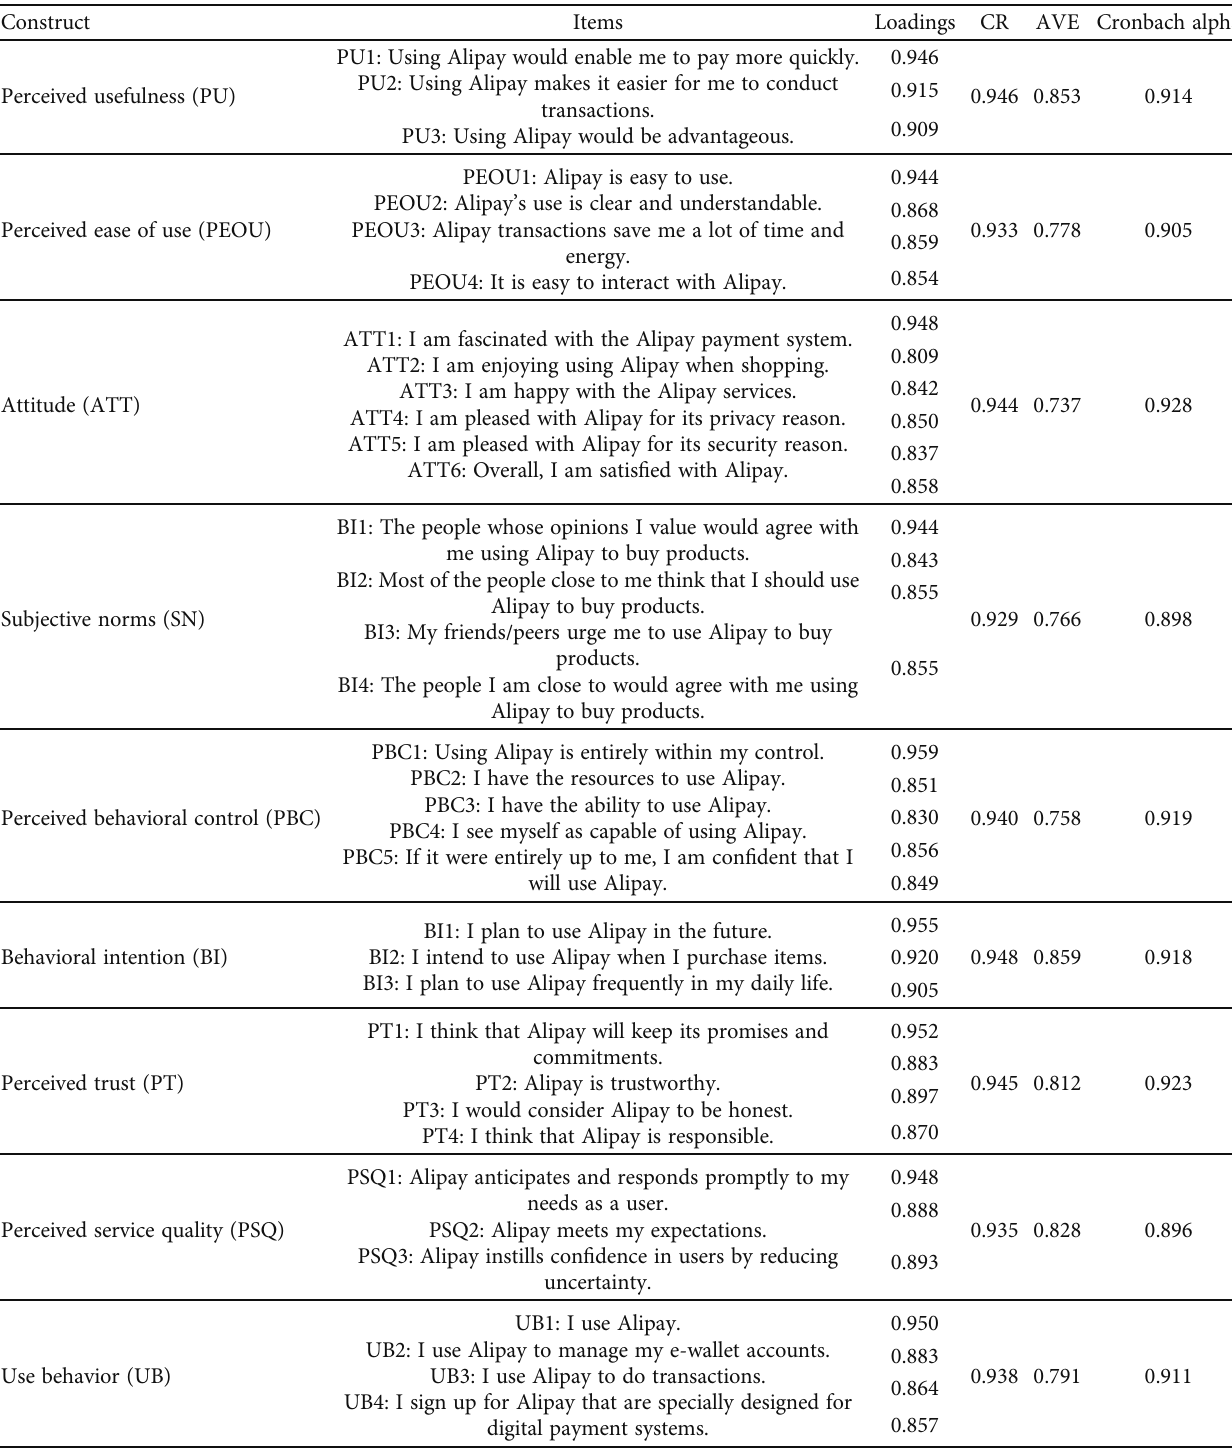
Table 1: Convergent